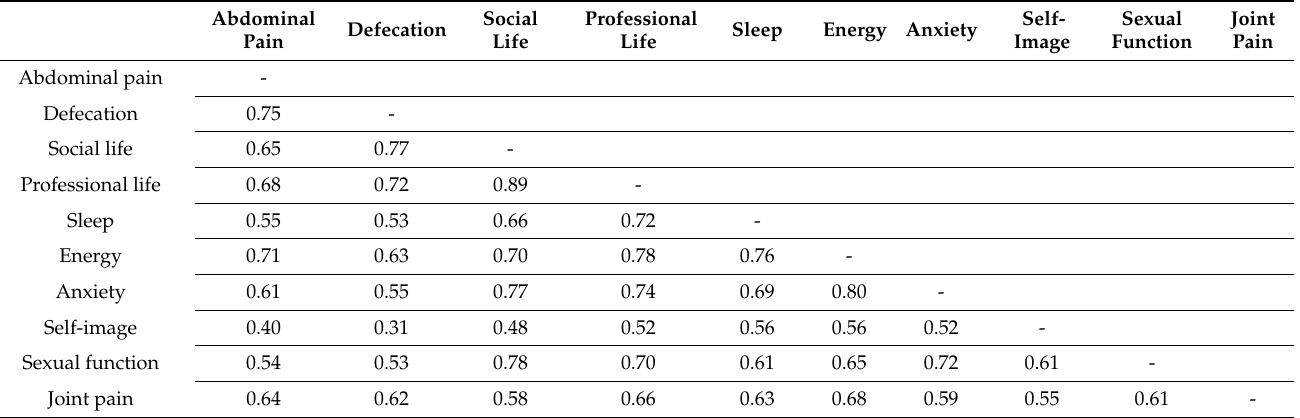
Table 3. Internal consistency reliability (Cronbach’s coefficient alpha) for each pair of the IBD-Disk items at baseline ( n =